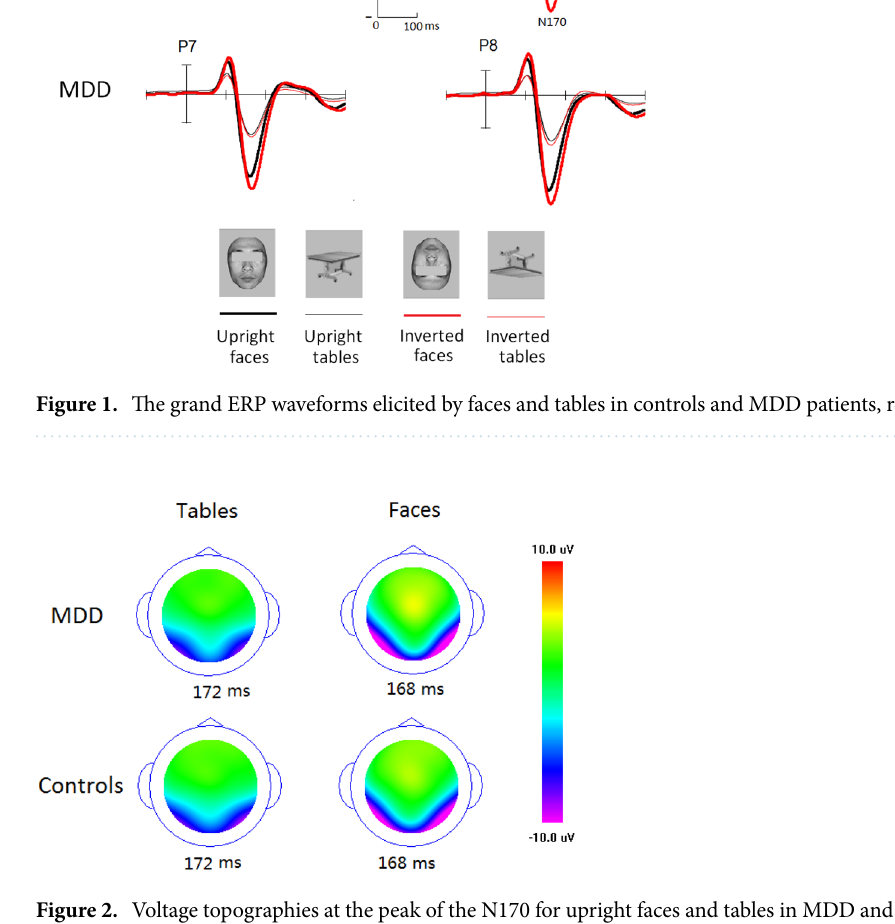
Figure 2. Voltage topographies at the peak of the N170 for upright faces and tables in MDD and controls,